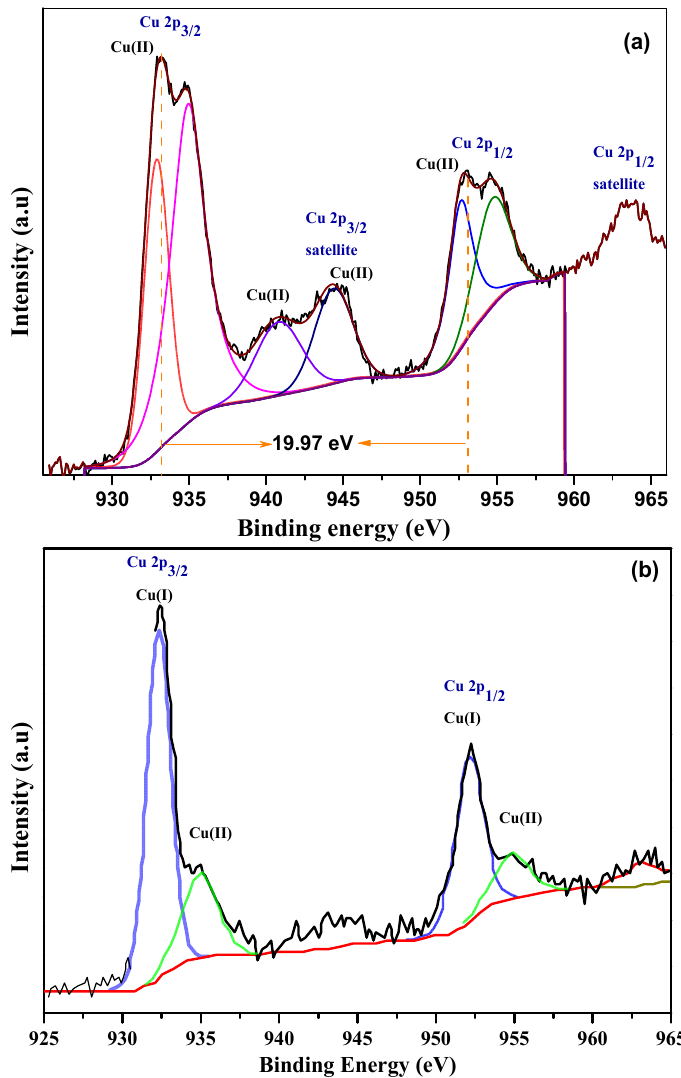
Figure 3. Deconvoluted XPS spectra of Cu 2p of ( a ) bulk fabricated CuO and ( b ) PSE-capped Cu 2 O/CuO materials fabricated by the aqueous solution combustion approach.